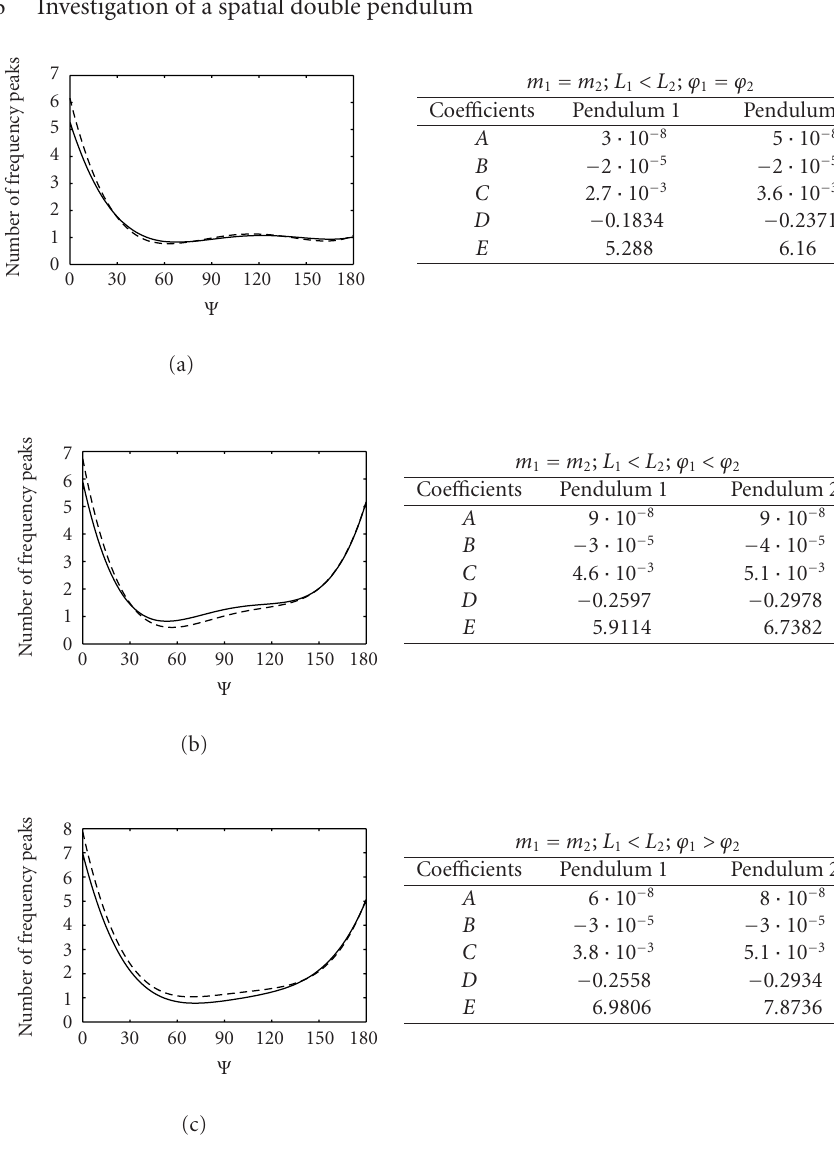
Figure 4.3. PDCP graphics for the cases in which m 1 = m 2 where 0 . 5kg < m 1 < 4kg and 5 L 1 < L 2